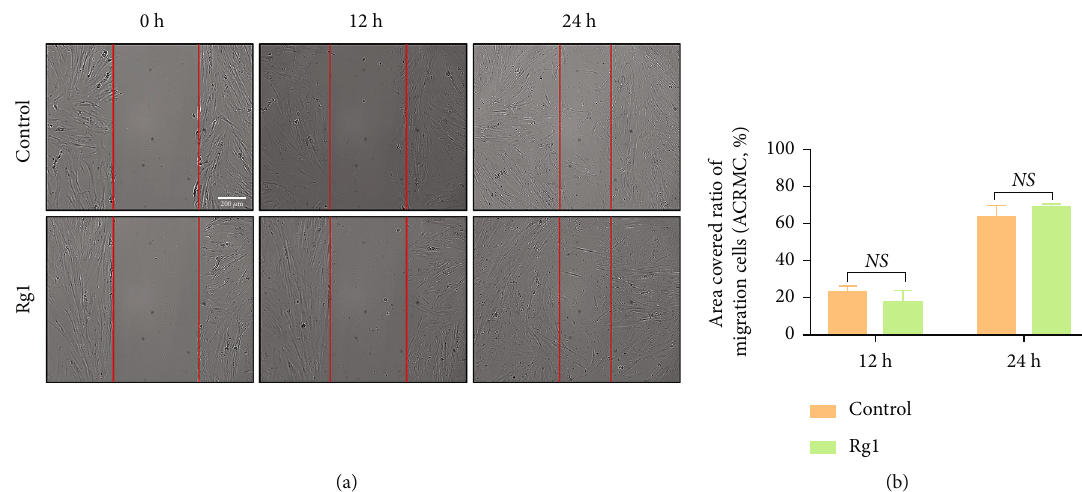
Figure 7: E ff ects of ginsenoside Rg1 on the migration of hAD-MSCs. (a) The migration of hAD-MSCs was tested by wound healing assay at 0, 12, and 24 h after Rg1 treatment in vitro , in the control, and Rg1 groups (100 × ). (b) The area-covered ratio of migration cells (ACRMC), which was de fi ned as (covered area/scratched area) × 100%, was compared between the control and Rg1 groups ( n =3). Scratched areas and uncovered areas of hAD-MSCs were highlighted with red lines. Representative images are shown. Scale bars =200 μ m. NS: not signi fi cant, ∗ P < 0 : 05 and ∗∗ P < 0 : 01